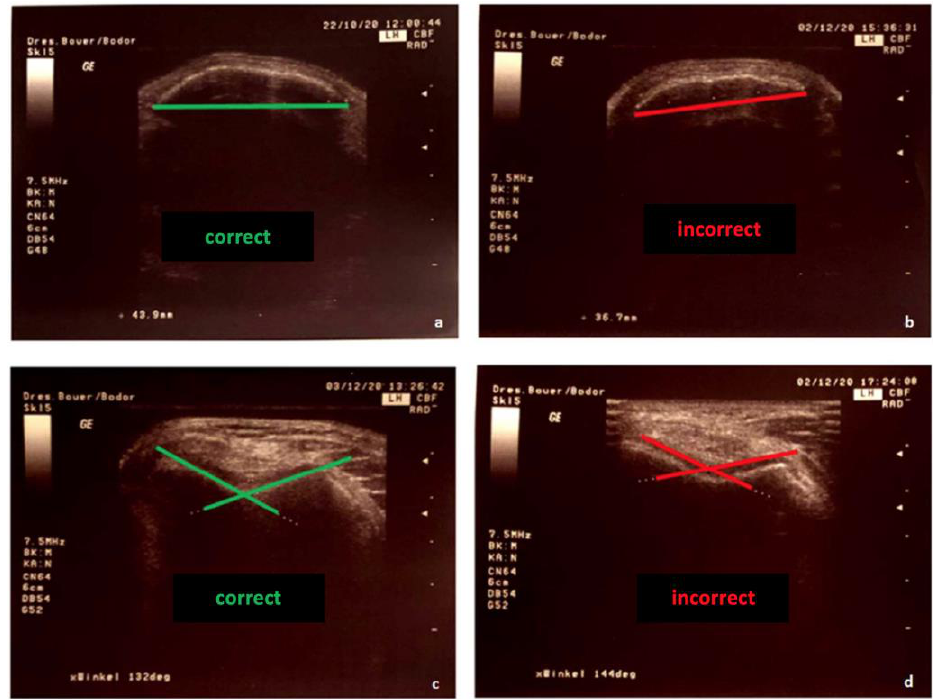
Figure 2. Image settings for sonographic measurement: ( a ) correct measurement of the patella diameter, ( b ) incorrect measurement plane, ( c ) correct positioning of the lines for the angle measurement, ( d ) incorrect positioning of the lines.